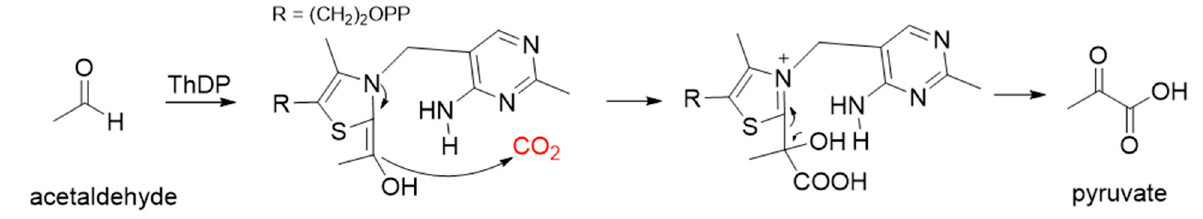
Figure 6. The synthetic malyl-CoA-glycerate (MCG) pathway [19]. PEPC, PEP carboxylase; MDH, malate dehydrogenase; MTK, malate thiokinase; MCL, malyl-CoA lyase; GCL, glyoxylate carboligase; TSR, tartronate semialdehyde reductase; GK, glycerate kinase; ENO, enolase.